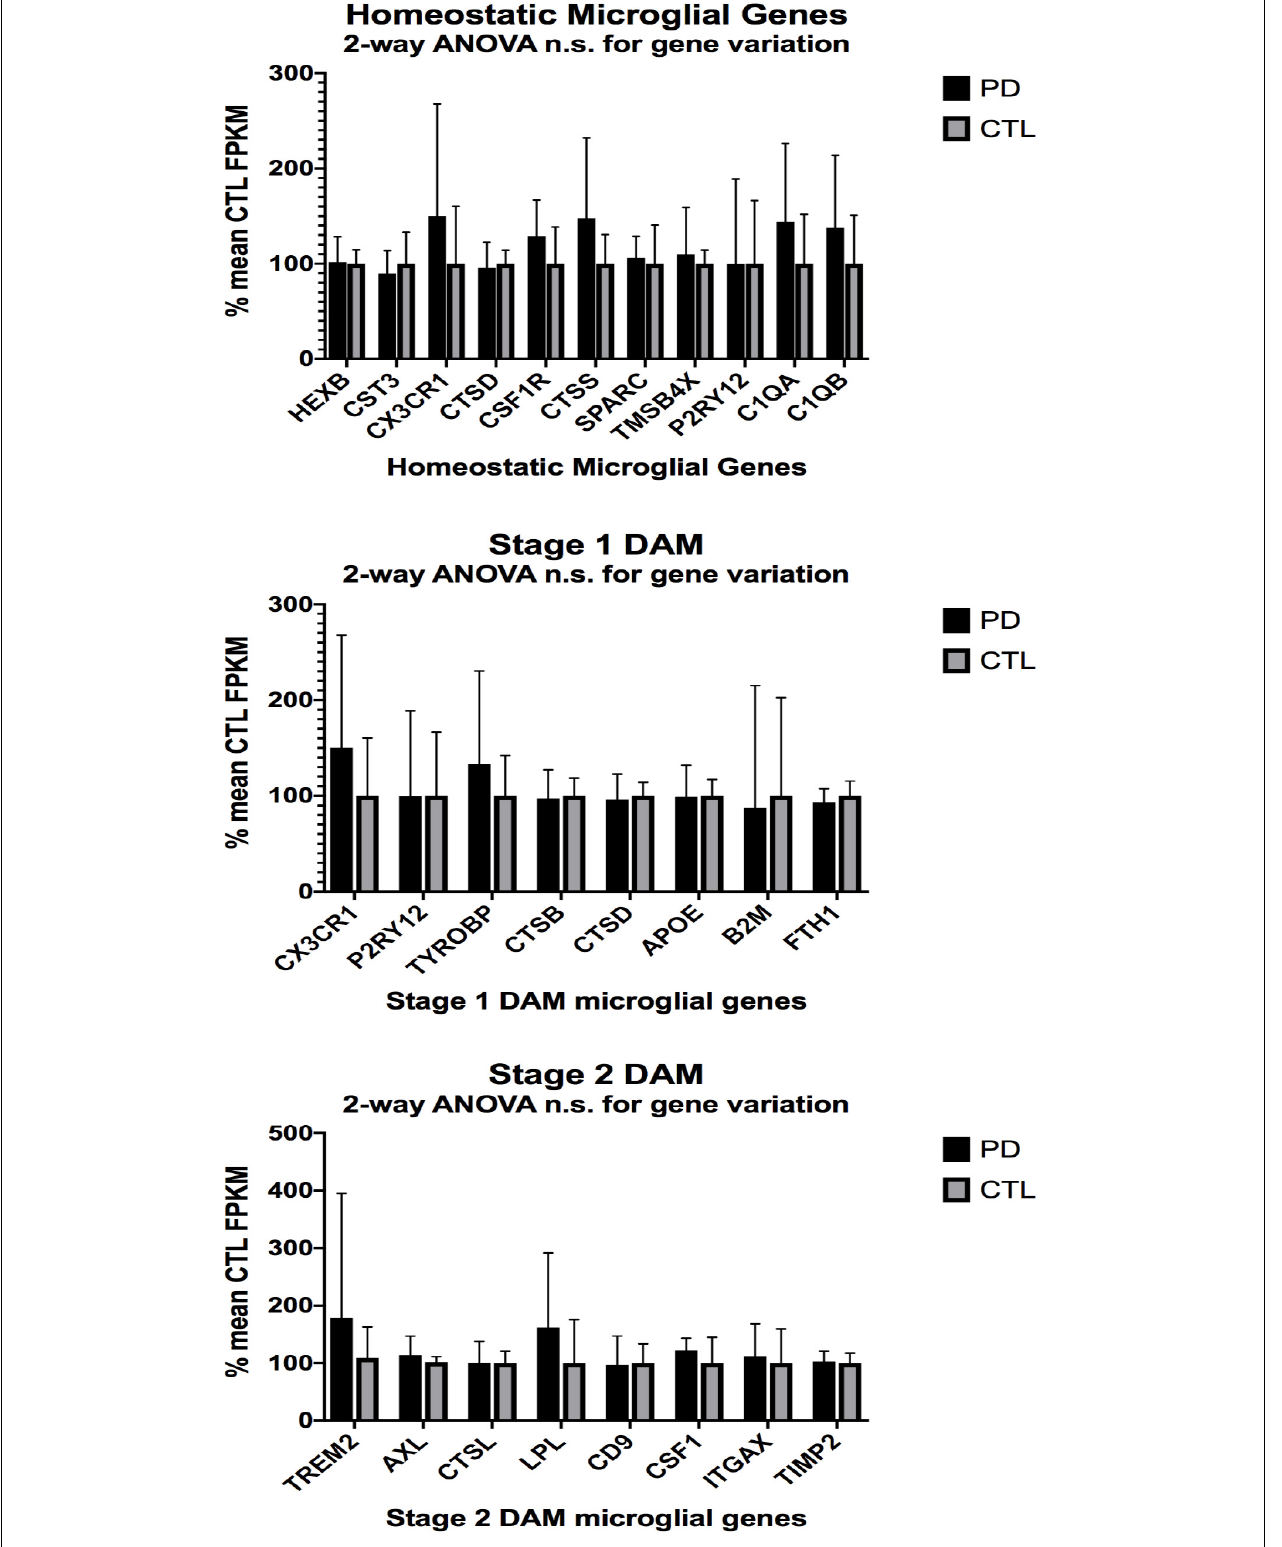
FIGURE 5 | Same as Figures 3 , 4 , except for PD ( n = 12) and CTL ( n = 8) ventral midbrain. No significant differences were detected by 2-way ANOVA or unpaired t -tests.